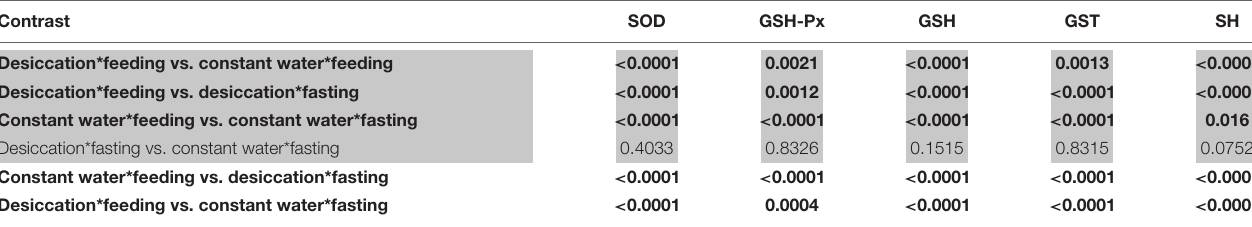
TABLE 2 | Multiple pairwise comparisons of oxidative stress parameters that displayed significant interaction with water regime × feeding regime (SOD, GSH-Px, GSH, GST, and SH groups). Contrast SOD GSH-Px GSH GST SH Desiccation*feeding vs. constant water*feeding <